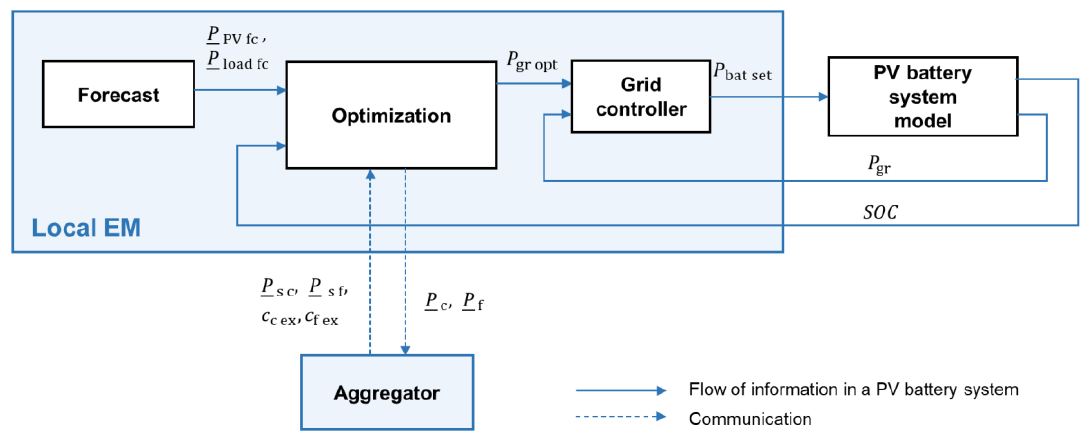
Figure 7. Principle structure of the local EM of a single PV battery system, featuring communication with the aggregator.